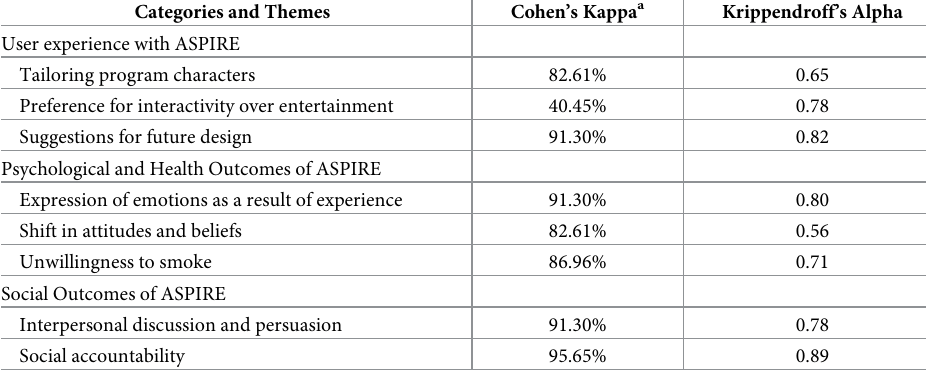
Table 2. Inter-coder reliability testing for each